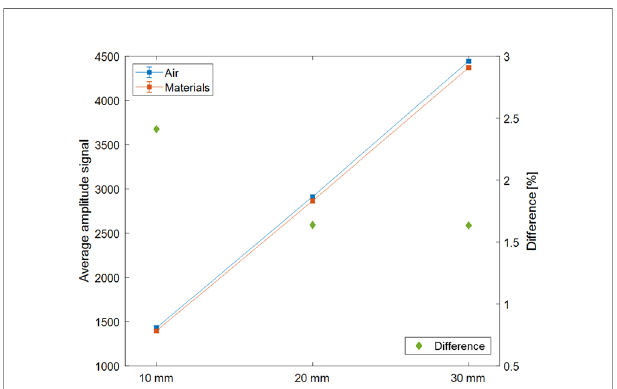
FIGURE 9 | Average measurement signal according to the type of materials between the sensor and magnet (air in blue; solid water phantom in orange) and the difference between the two average signals (in green and ◆ ) expressed according to the amplitude (P-P) of the motion